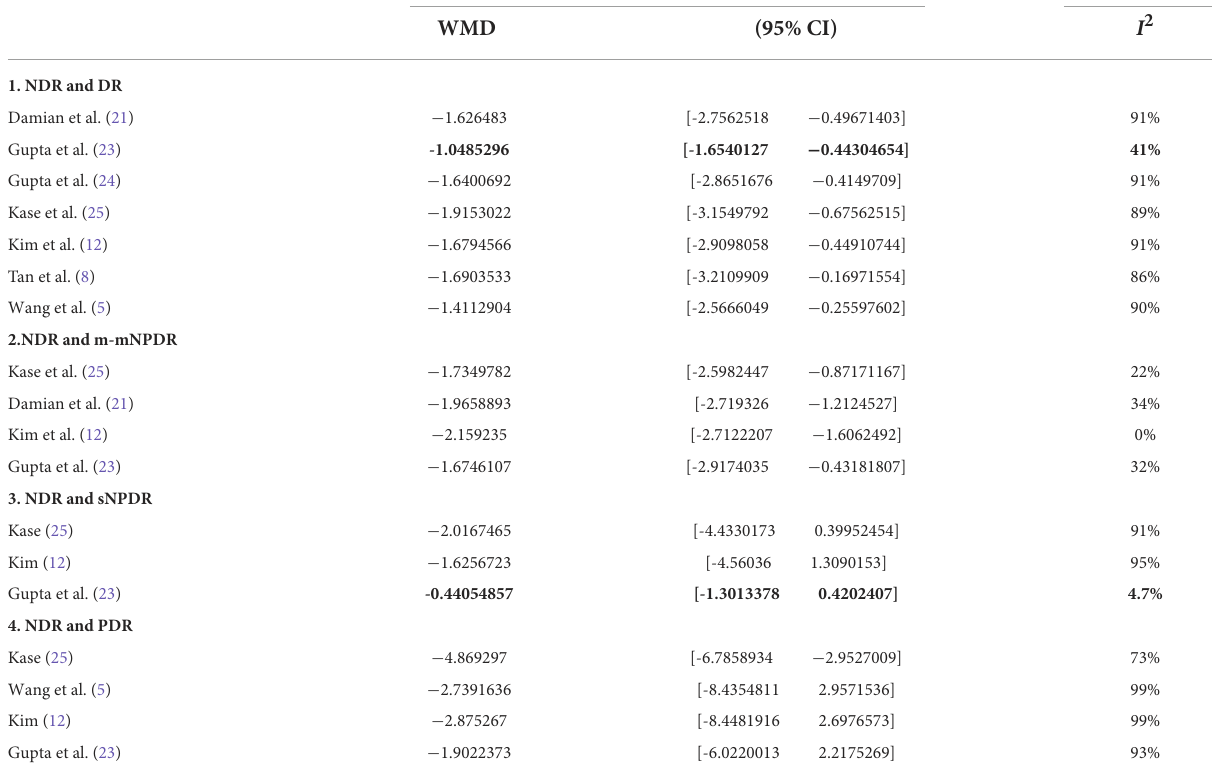
TABLE 4 Sensitivity analysis of CVI in DR